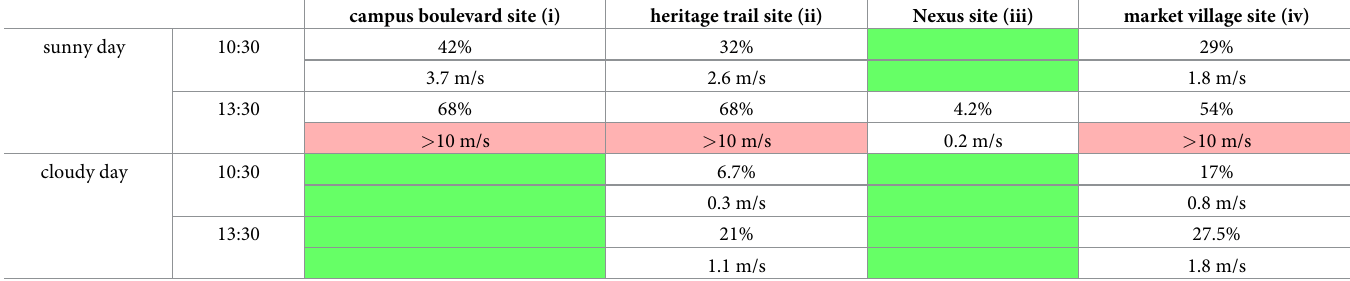
Table 4. The table summarizes the conditions to achieve PTA = 0.5 from Figs 9(D), 10(D), 10(E), 11(D), 12(D) and 12(E). In each cell, the upper panel is the required shade percentage, and the upper panel is the required increasing wind speed. The cells in green represent that PTA � 0.5 can be naturally achieved. The cells in red represent that cannot be achieved by only increasing the wind speed in a reasonable range of up to 10